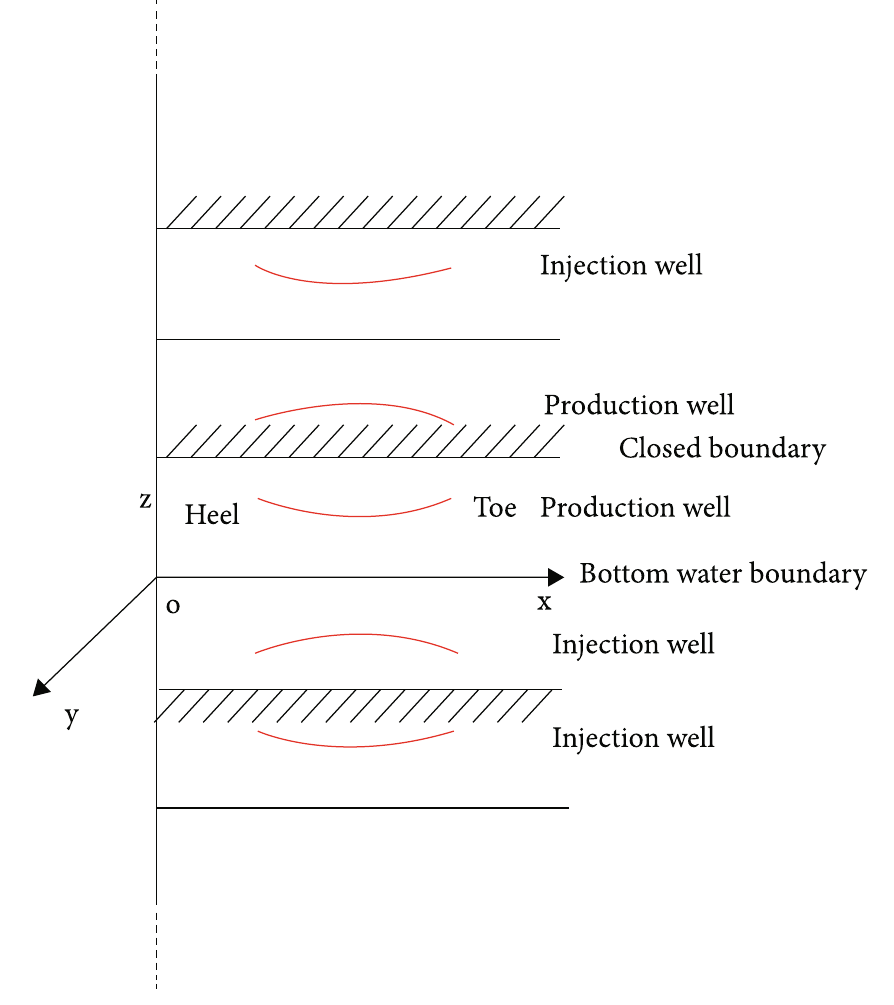
Figure 3: Mirror image of horizontal well in bottom water drive reservoir.